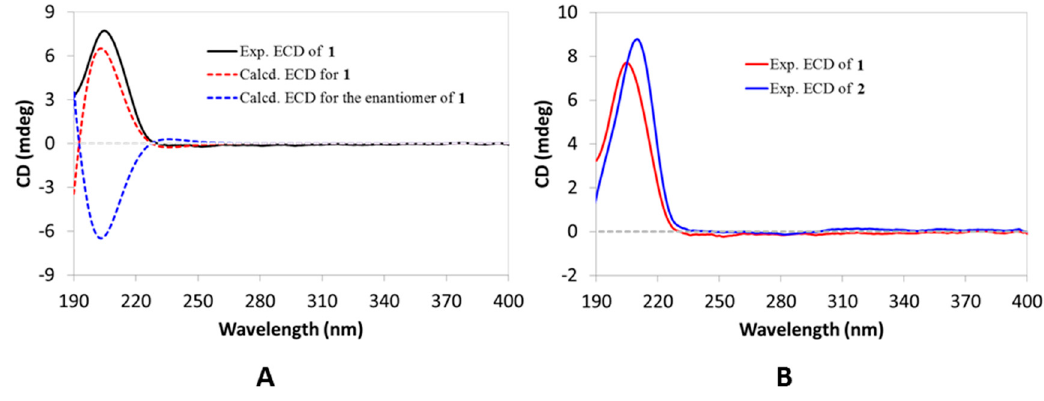
Figure 3. ( A ) Experimental ECD spectrum of Compound 1 (black) compared with the calculated ECD spectra of 1 (red) and its enantiomer (blue). ( B ) Experimental ECD spectra of Compound 1 (red) and Compound 2 (blue).